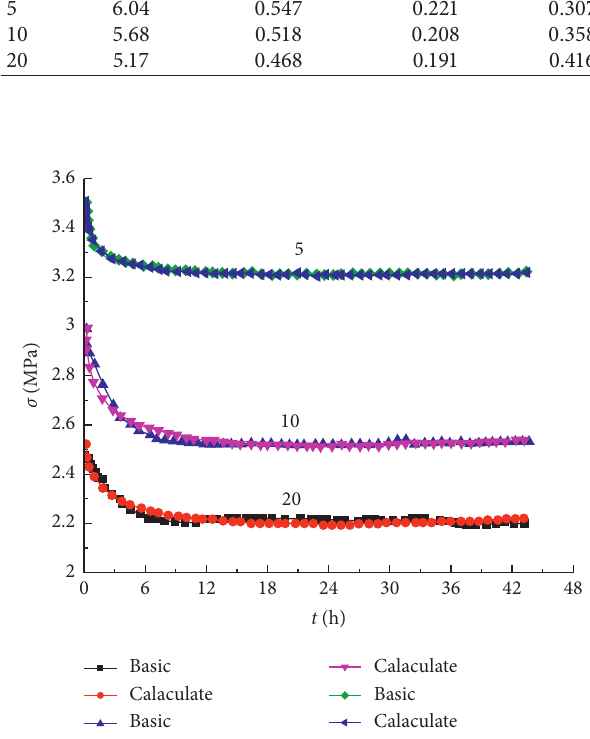
Figure 7: Comparison of rock stress between the experimental data and predicted